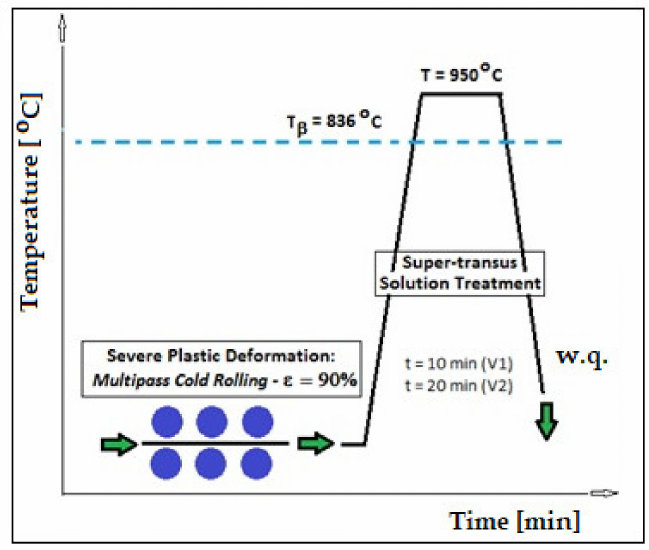
Figure 2. Schema for the thermomechanical processing of the studied Ti–Nb–Zr–Fe–O alloy by severe plastic deformation and solution